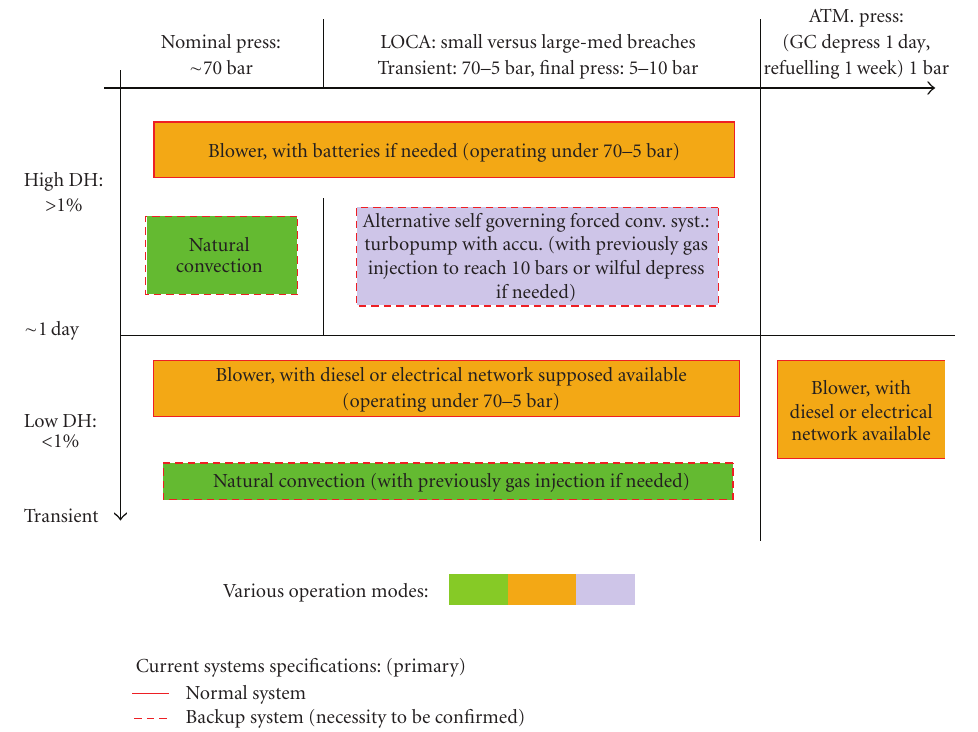
Figure 2: Schematic of the DHR strategy based on mixed natural and forced mechanisms